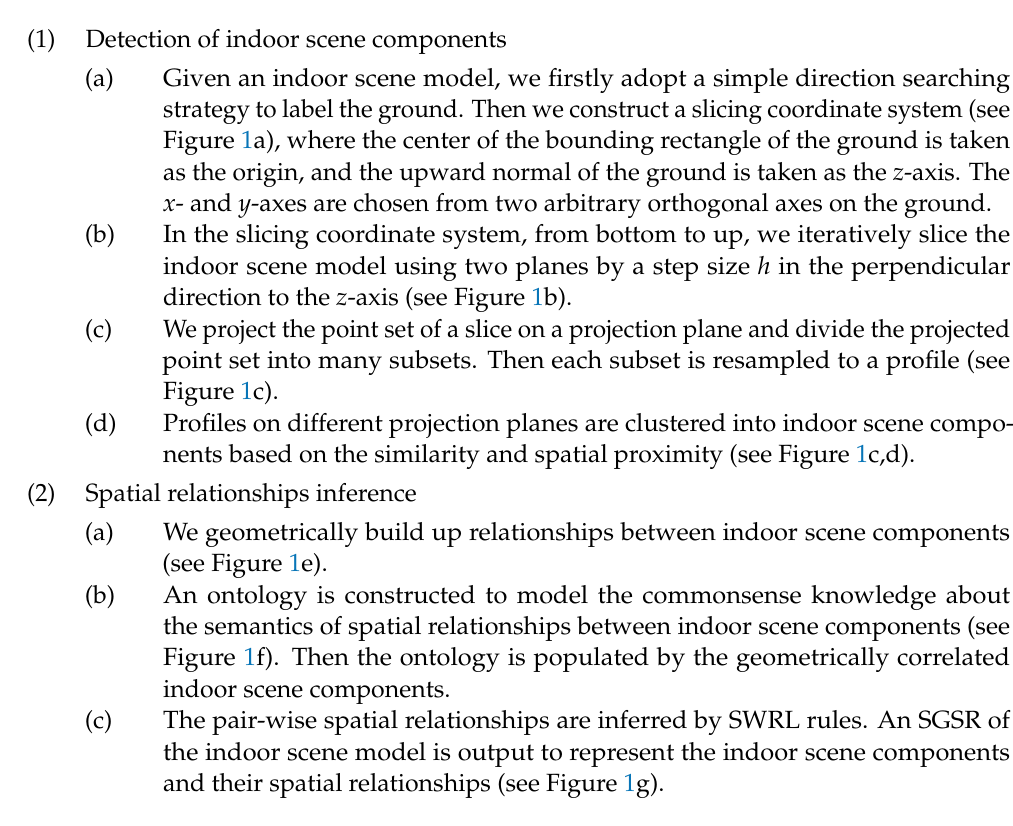
Figure 1. The framework of the proposed method: ( a ) Input an indoor scene model; ( b ) Slicing the indoor scene model; ( c ) Generate the profiles; ( d ) Cluster profiles into different indoor scene components; ( e ) Construct the relationship graph; ( f ) Build up an ontology to model knowledge about indoor scene components; ( g ) Infer spatial semantics and output SGSR of the input scene